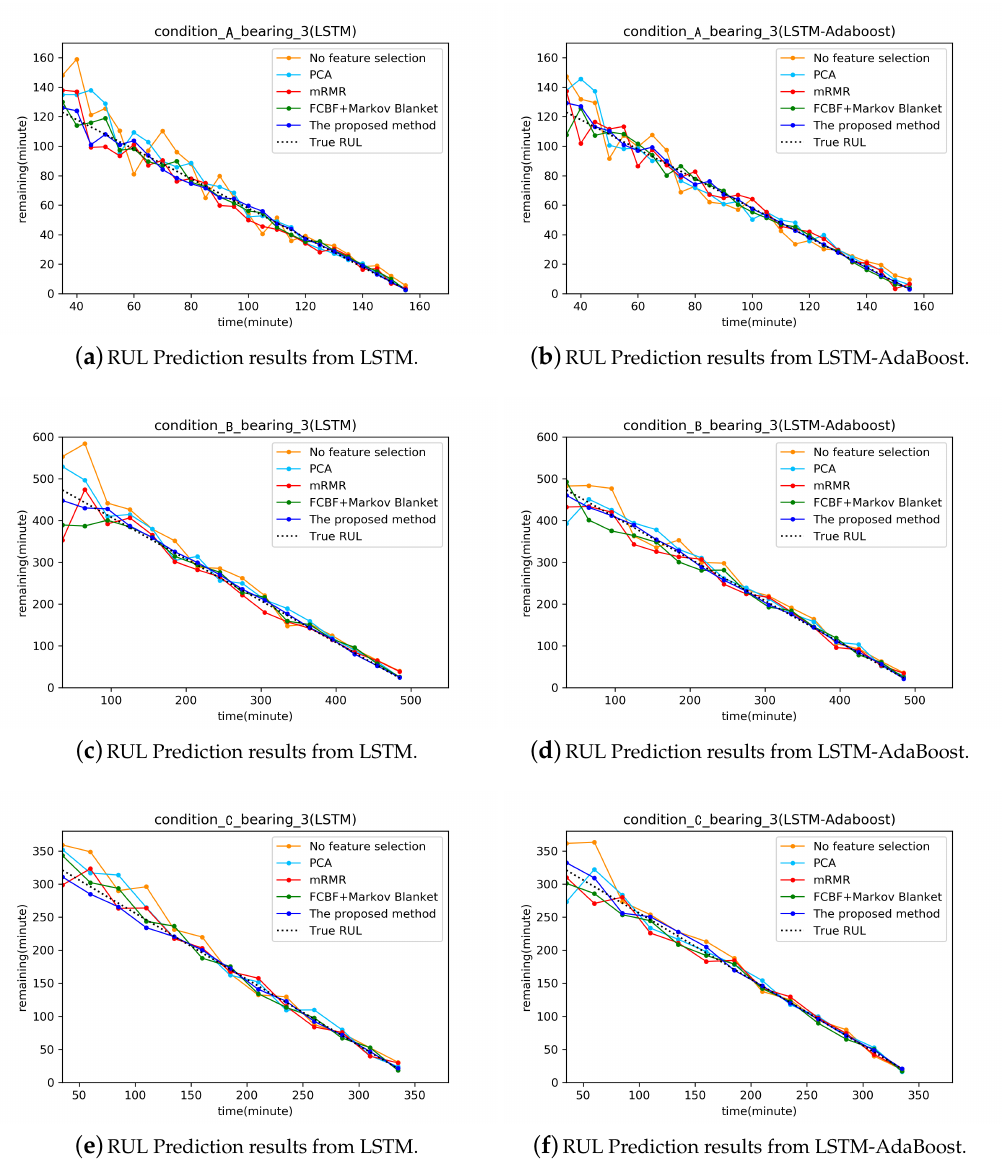
Figure 13. RUL prediction resultsusing three different features selection methods for three